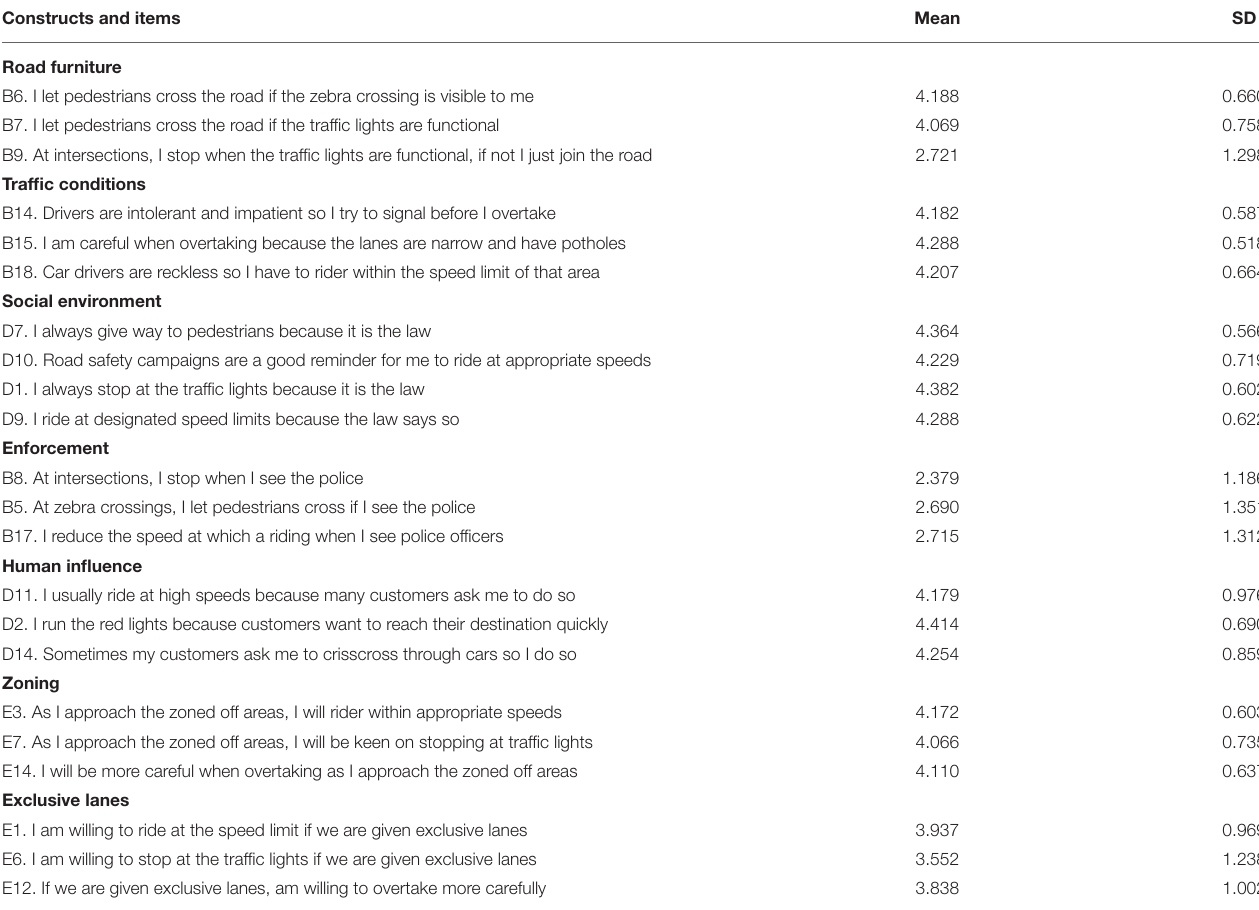
TABLE 3 | Descriptive statistics of measurement